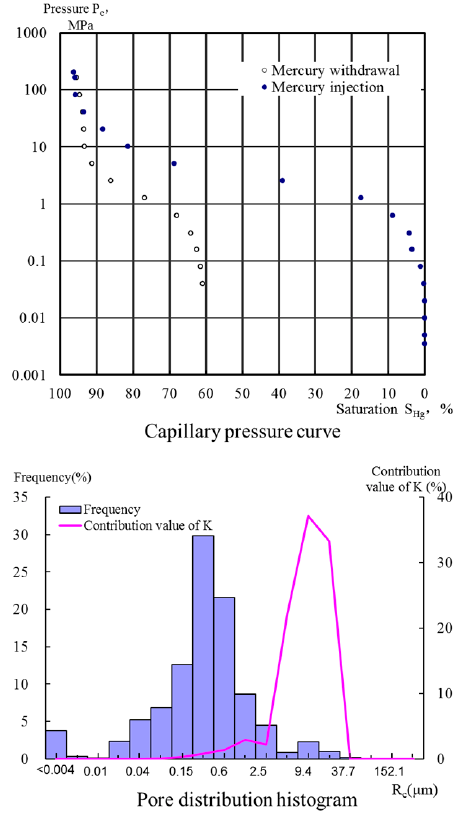
Figure 12. Plot showing capillary pressure curve of Callovian-Oxfordian Stage.